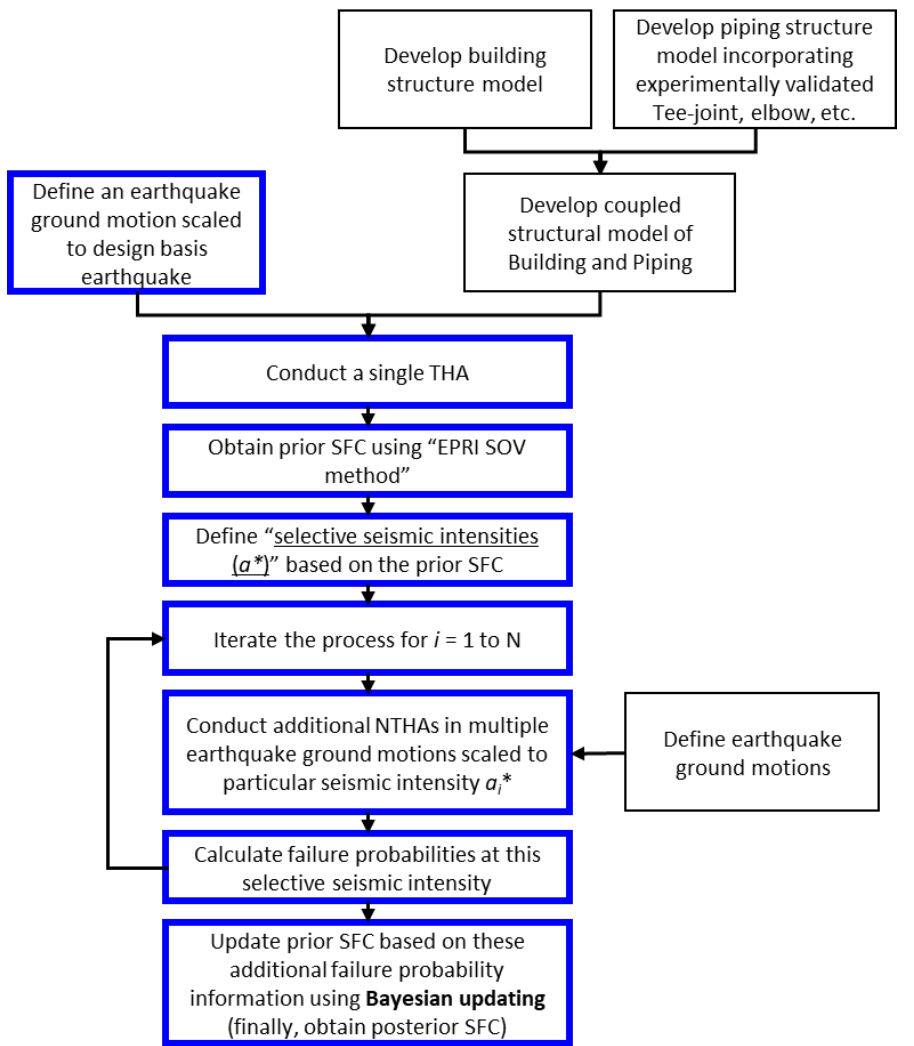
Figure 3. Proposed process of the piping seismic fragility evaluation based on the EPRI (Electric Power Research Institute) separation of variable (SOV) method and Bayesian